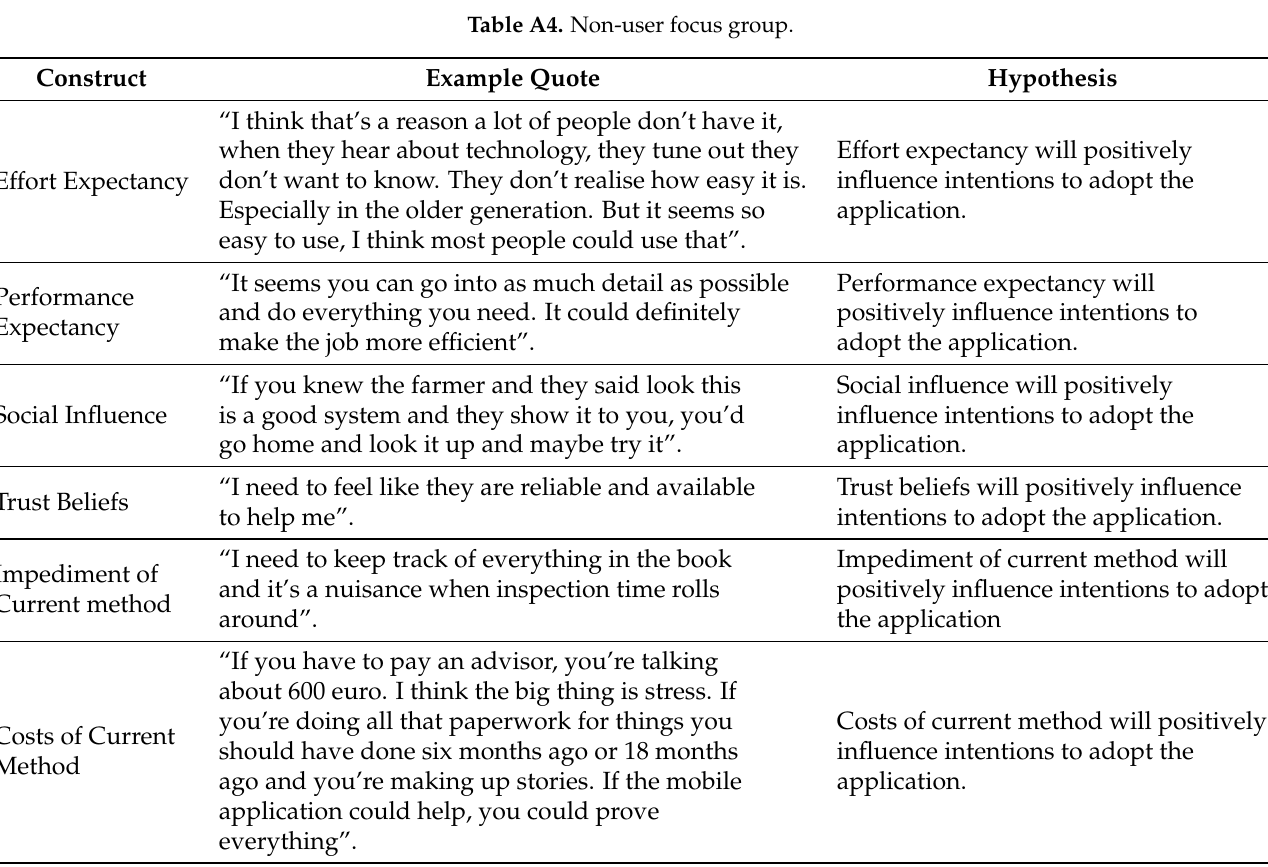
Table A4. Non-user focus group.